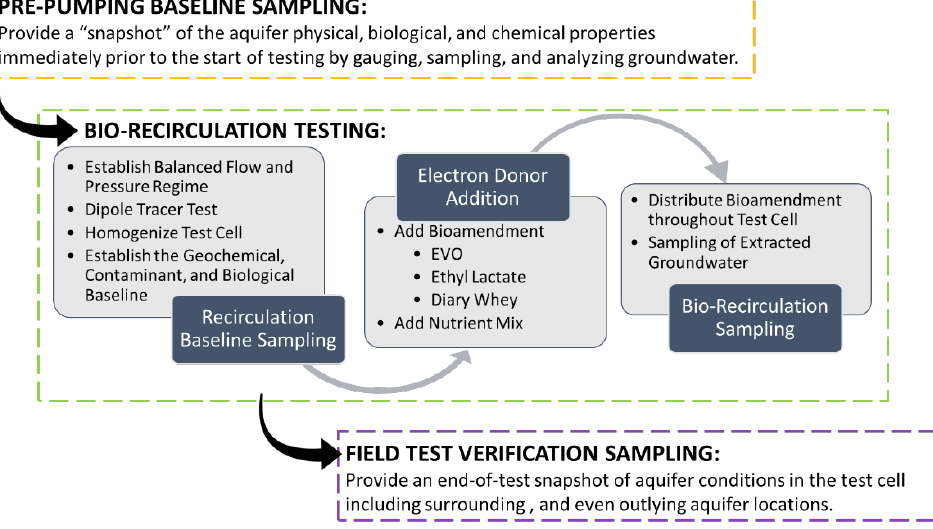
Figure 4. Field test plan procedure flow chart.